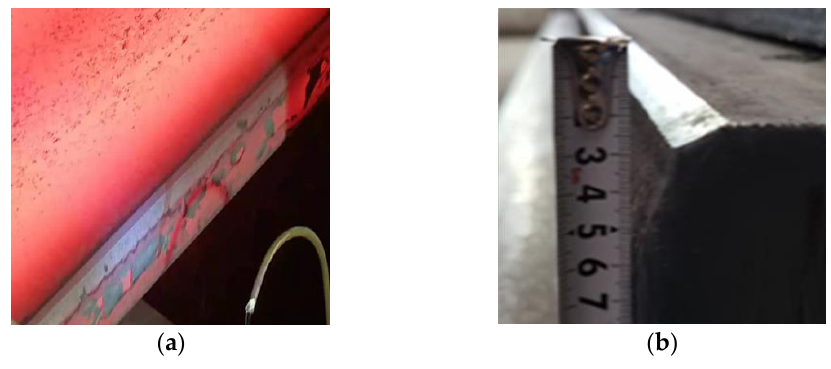
Figure 16. Industrial applications of two-chamfered equipment. ( a ) Horizontal rolling; ( b ) frontal rolling with a two-roller.